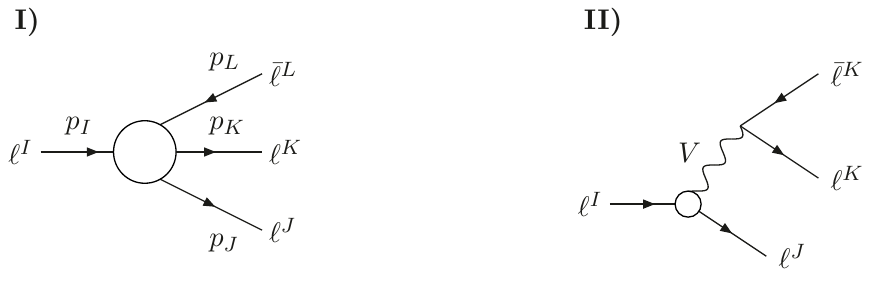
Figure 5 . Diagrams contributing to ‘ I ! ‘ J ‘ K (cid:22) ‘ L decay. I): 1PI irreducible box diagrams; II): penguin diagrams with V = Z; (cid:13); h; H or A . For K = J crossed diagrams must be also